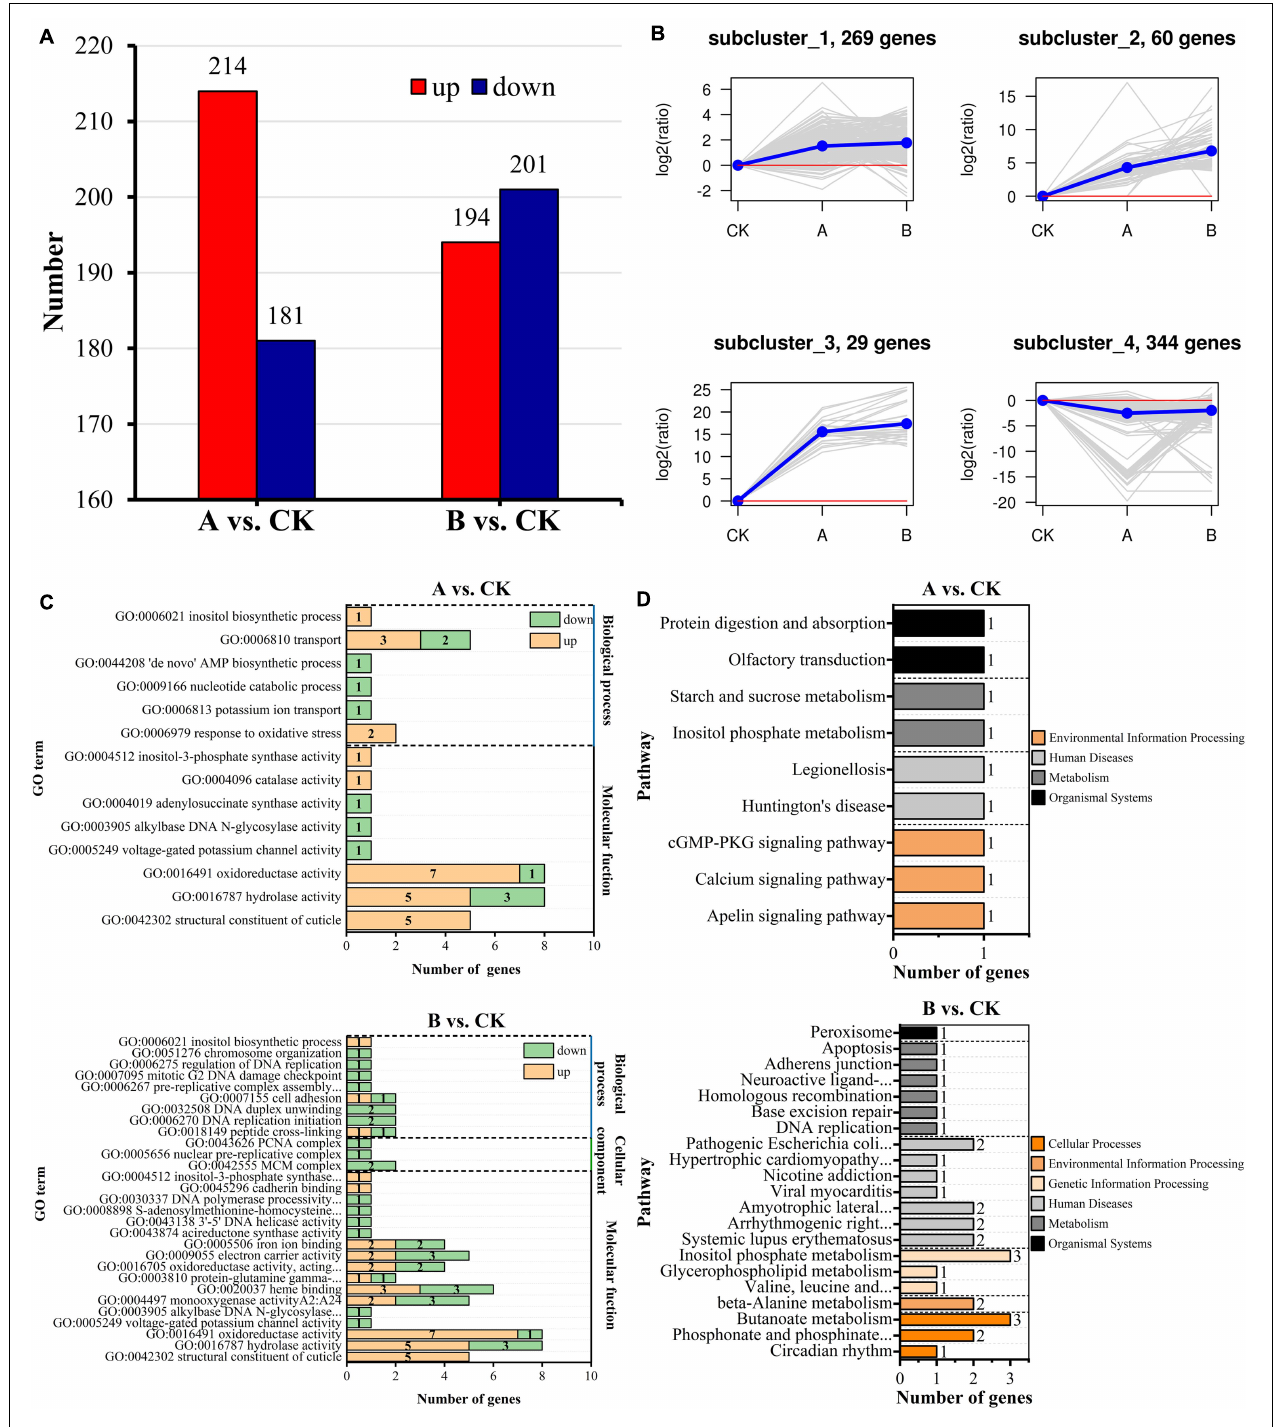
FIGURE 5 | Identification, clustering, and functional enrichment analyses of DEGs. (A) Statistics of the number of DEGs. (B) Analyses of expression patterns. (C) Significant enrichment map of GO terms. (D) Significant enrichment map of KEGG pathways.